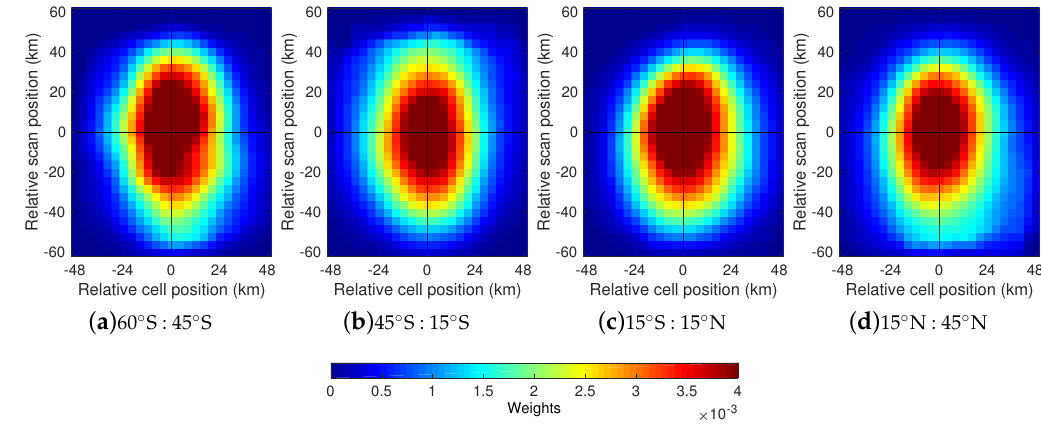
Figure 11. Footprints representing across-track averages in four latitude